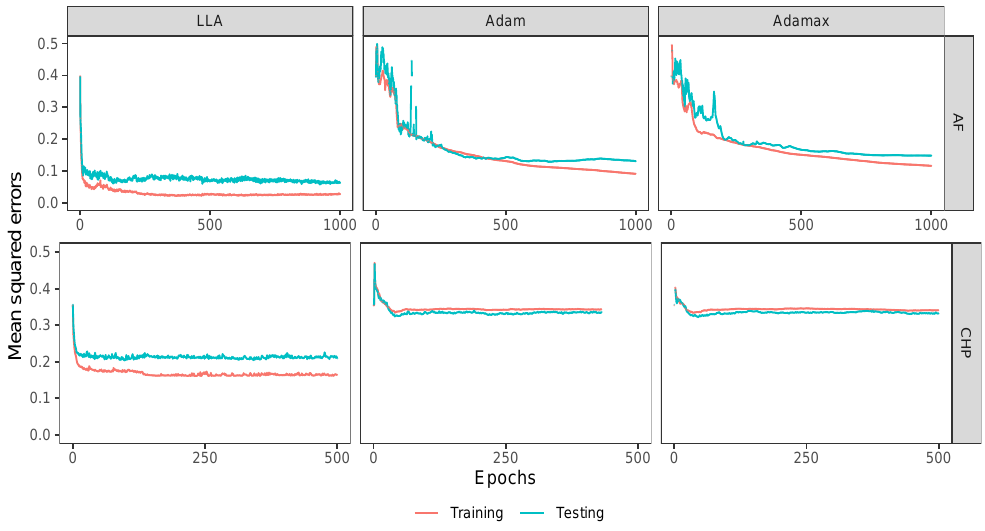
Figure 3. MSE of LLA, Adam and Adamax algorithms versus the number of